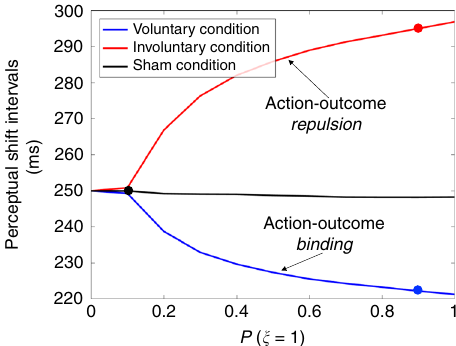
Fig. 2 Bayesian model predictions of the in fl uence of causal prior strength on action-outcome perceptual shifts. The best estimates of the Bayesian model (in Fig. 1) were obtained from different causal priors, speci fi cally, P ( ξ = 1) is 0.9, 0.9, and 0.1 (marked by the colored dots) for the voluntary, involuntary, and sham conditions, respectively. The intervals between the action and outcome perceptual shifts shrink in the voluntary, but widen in the involuntary, condition with a strong causal prior. Minimal changes in perceptual shifts are predicted for the sham condition even with a